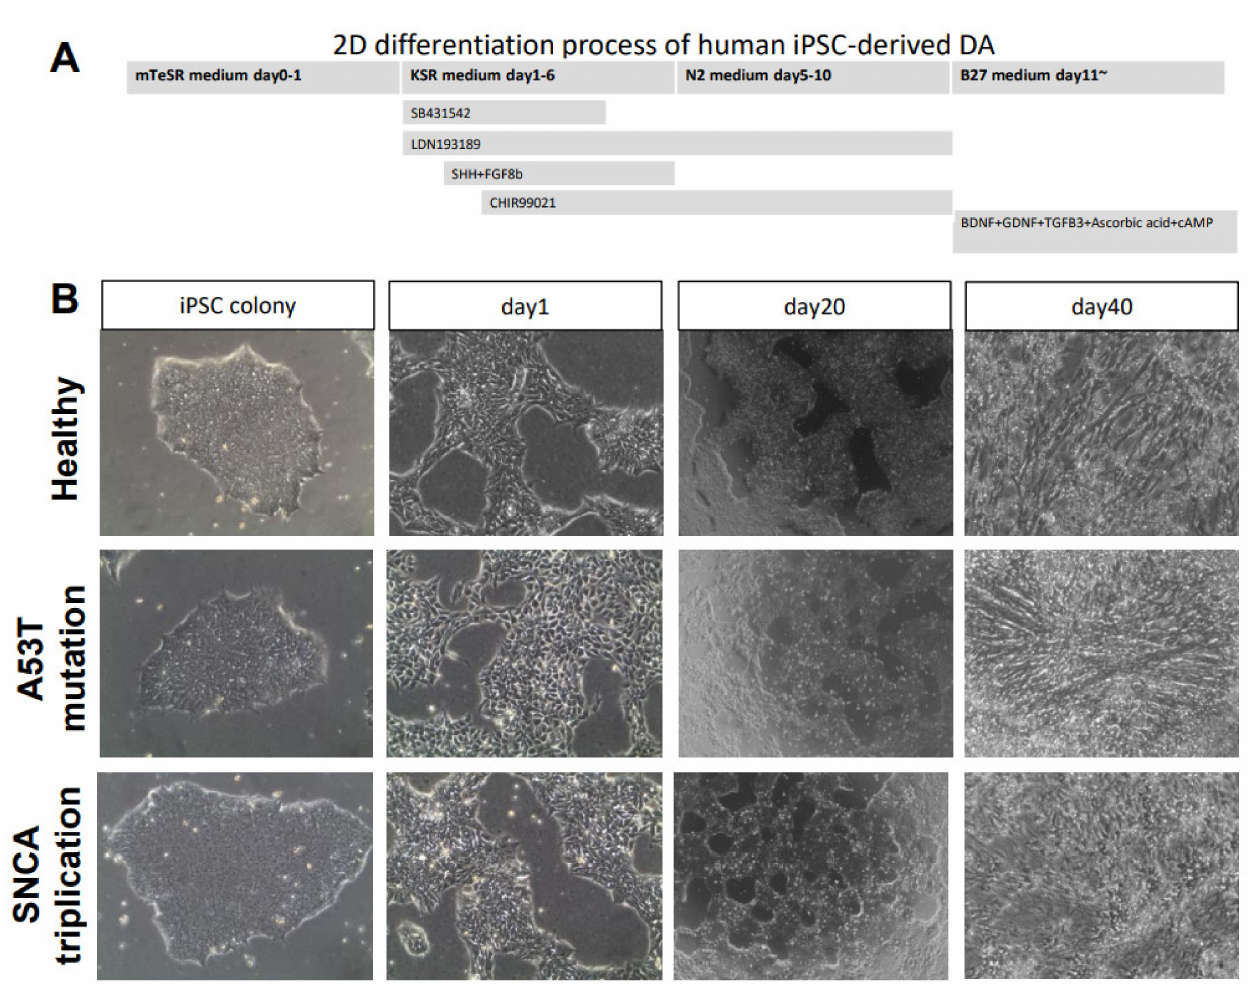
Figure 1. Differentiation of iPSCs to mDA neurons. ( A ) Experimental paradigm for human iPSC differentiation toward mDA neurons. ( B ) Morphology of healthy and PD patients’ cell lines at different stages during differentiation from iPSC into mature mDA